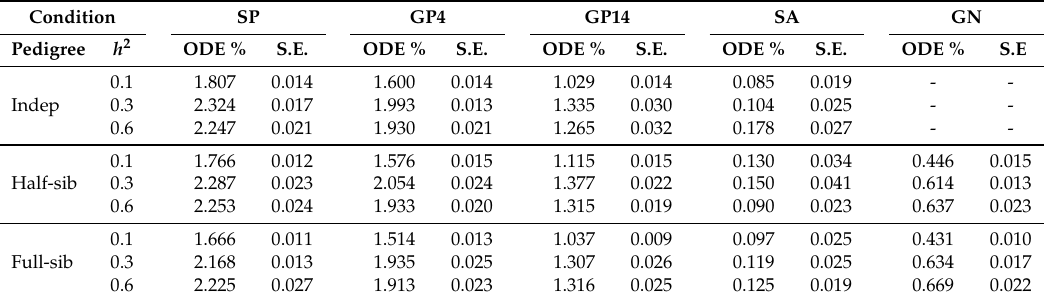
Table 4. Average ODEs reported together with standard errors (S.E.) for simple pairwise (SP), greedy pairwise (GP4 and GP14), simulated annealing (SA) and genetic neighborhood (GN) procedures for Ω ( 30 ) RCB designs at a spatial correlation of D